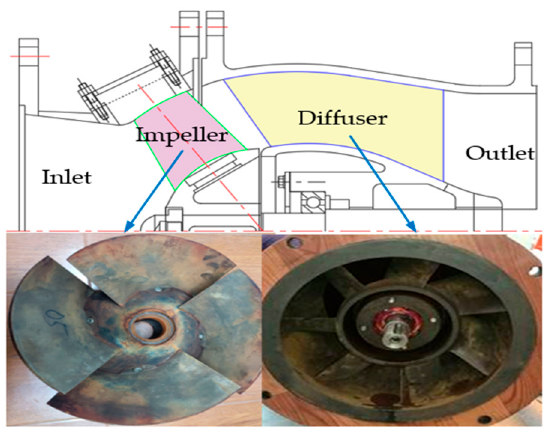
Figure 1. Baseline model .